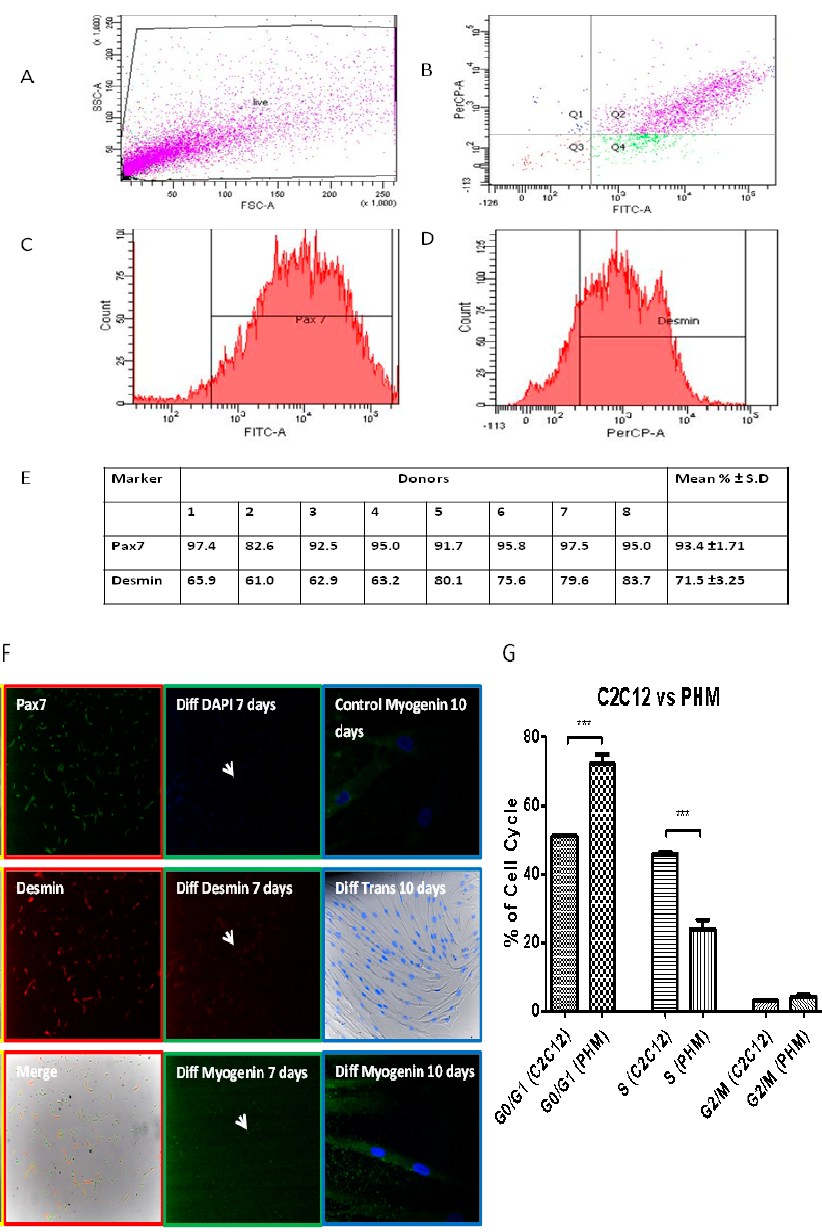
Figure 7. The phenotypic characterization of primary human myoblasts. ( A – D ) Flow cytometric analysis of Primary Human myoblasts (PHMs) was performed as described in Materials and Methods section. Average of cells (%) staining positive for Pax7 and desmin are shown. ( E ) Several preparations of the PHMs were analyzed and shown is representative of eight donors. Results are shown as mean ± S.D. ( F ) Red outlined column (first column): Preliminary characterization of isolated cells as performed to ascertain whether the culture generated contained myoblasts: Pax7 (green), desmin (red) (fluorescent microscopy at 100 × magnification). Green outlined Column (second column): PHMs were exposed to di ff erentiation inducing conditions for 7 days and stained via immunofluorescence for desmin (red), myogenin (green) and nuclei (blue). White arrows indicate multinucleated myofibres. Blue outlined Column (third column): PHMs were able to preserve their di ff erentiation ability after long periods of sub-culturing. Cells were maintained and passaged for two months (imaged by confocal microscopy (myogenin) at 400 × magnification or fluorescent microscopy (Trans) at 200 × magnification). ( G ) Comparison of C2C12 and PHMs. Cells were analyzed through flow cytometry and percentages of cells in each cell cycle stage quantified. * p < 0.05; ** p < 0.01; *** p <